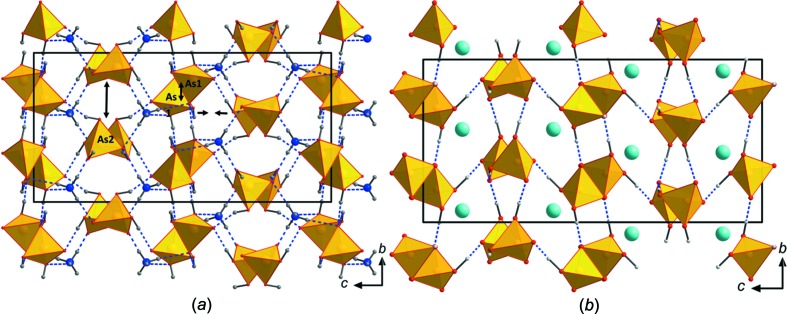
Comparison of (a) homeotypic (NH4)(H2AsO4)(H3AsO4) with (b) Rb(H2AsO4)(H3AsO4) (Naili & Mhiri, 2001 ▸). A shift (arrows in figure) of As1 in the b direction leads to a compression of the whole structure along c, and results in a change of the hydrogen-bonding network. Hydrogen bonds connecting As2O4 tetra­hedra along b are lost in (NH4)(H2AsO4)(H3AsO4), but new hydrogen bonds now connect As1O4 and As2O4 along c.